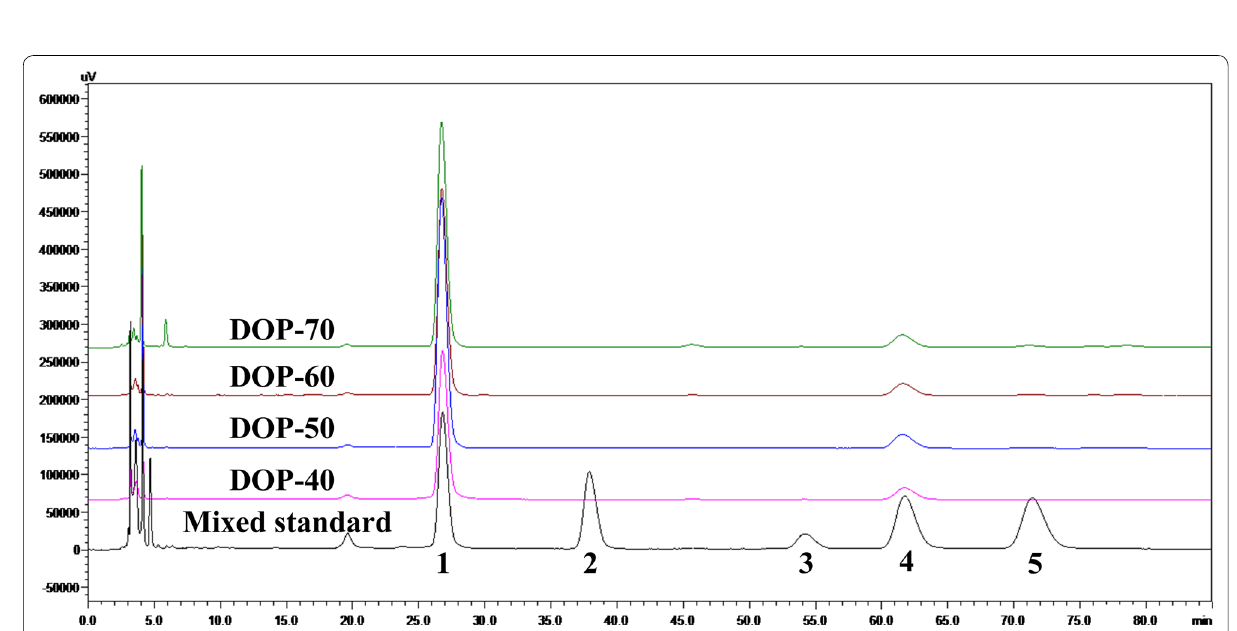
Fig. 4 HPLC profile of mixed monosaccharide standards (1-mannose, 2-rhamnose, 3-galactose, 4-glucose, and 5-arabinose), DOP-40, DOP-50, DOP-60, and